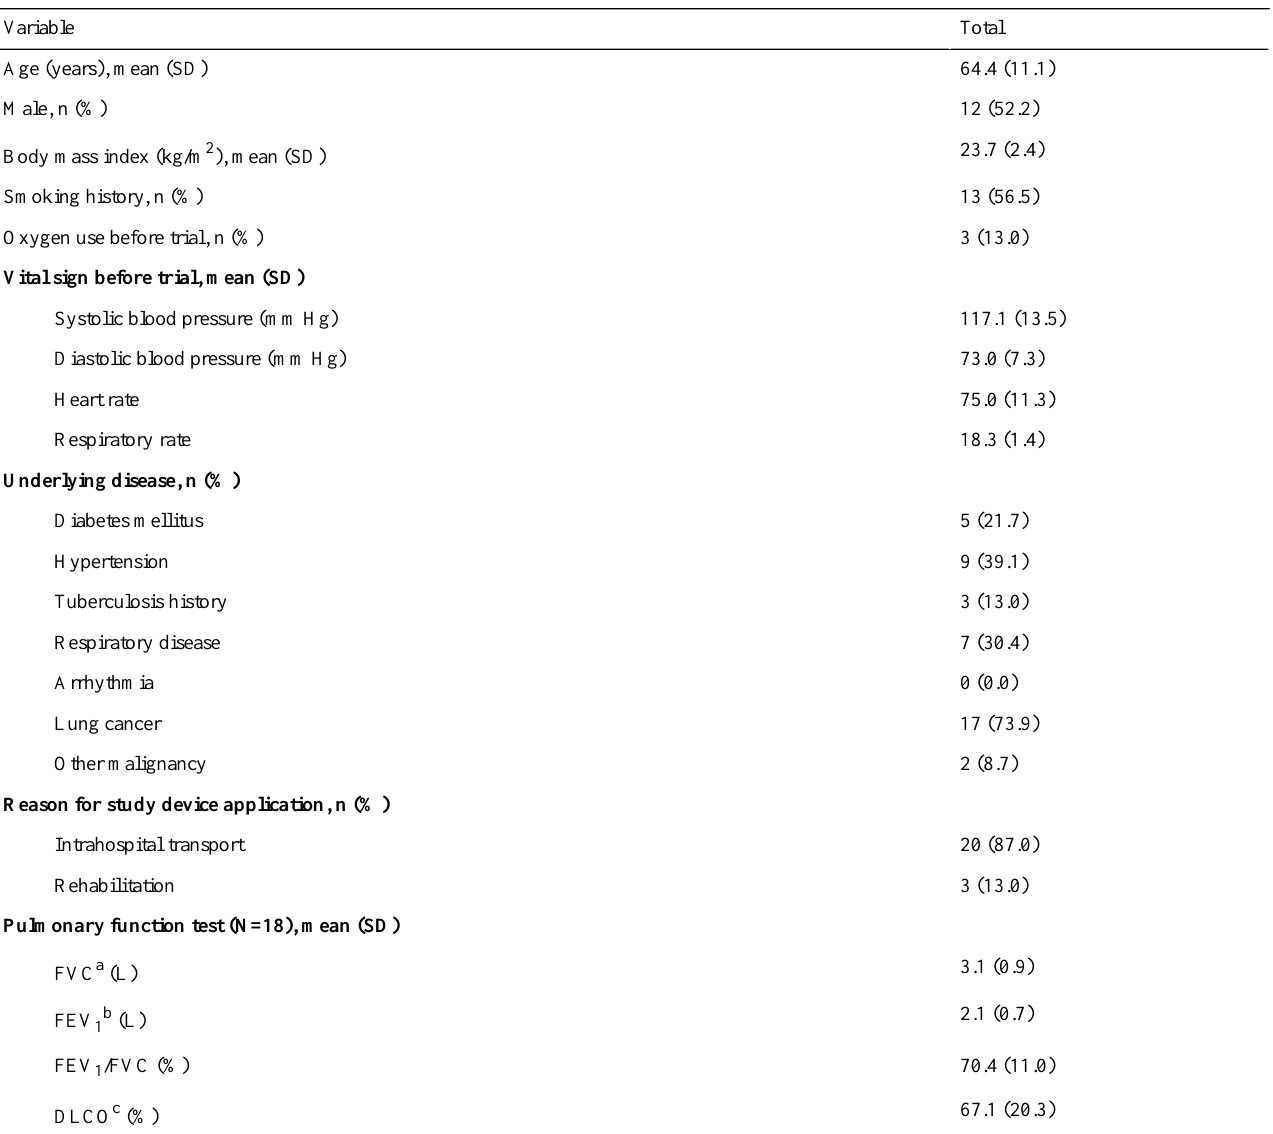
Table 1. Basic characteristics of patients